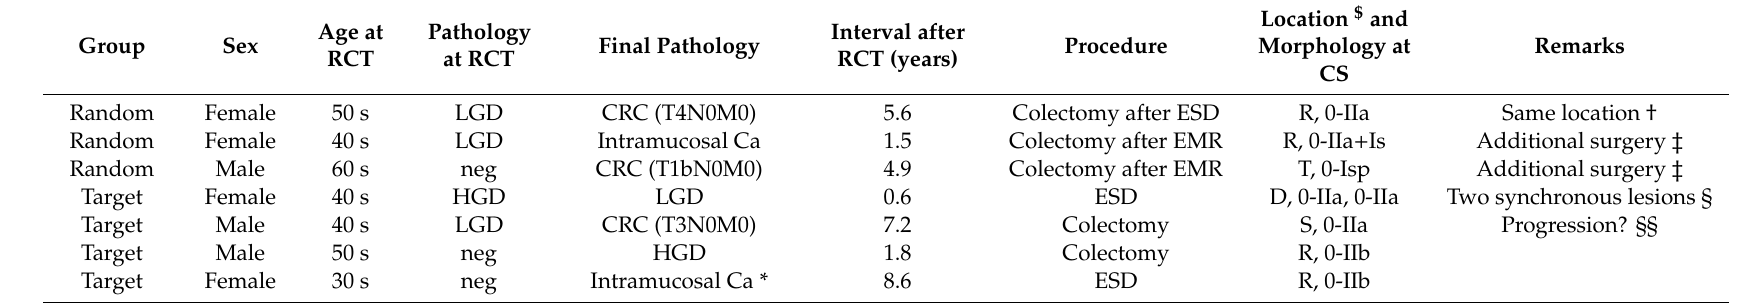
Table 3. Cases with high-grade dysplasia or cancer at some